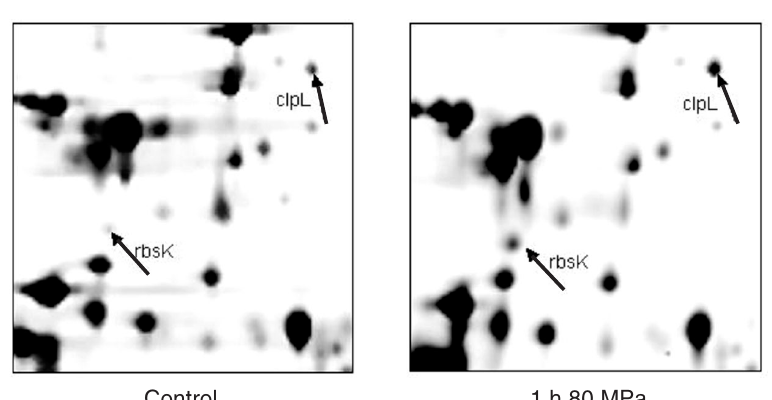
Figure 1. High pres- sure-inducible proteins in Lactobacillus san- franciscensis as deter- mined by 2-D gel elec- trophoresis. Cells were treated for 1 h at 80 MPa and 30 º C. The squares and numbers indicate upregulated proteins. MW = molec- ular